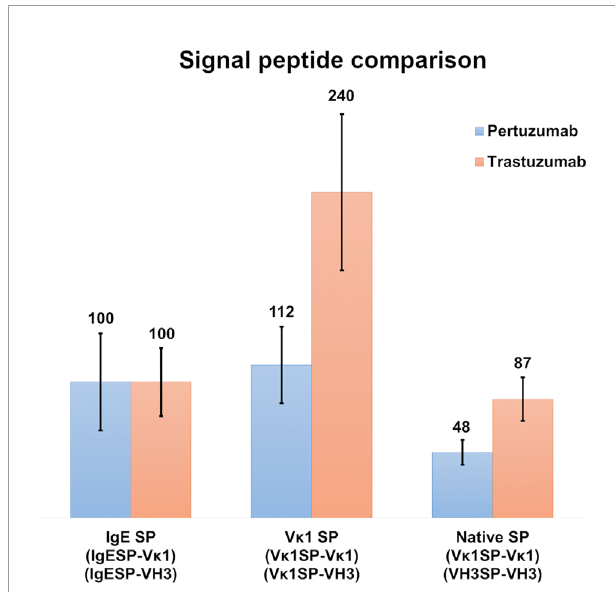
FIGURE 3 | Recombinant antibody production rates of wild-type V k 1|VH3 Pertuzumab (blue) and Trastuzumab (orange) using the IgE, V k 1 and native SPs in %.